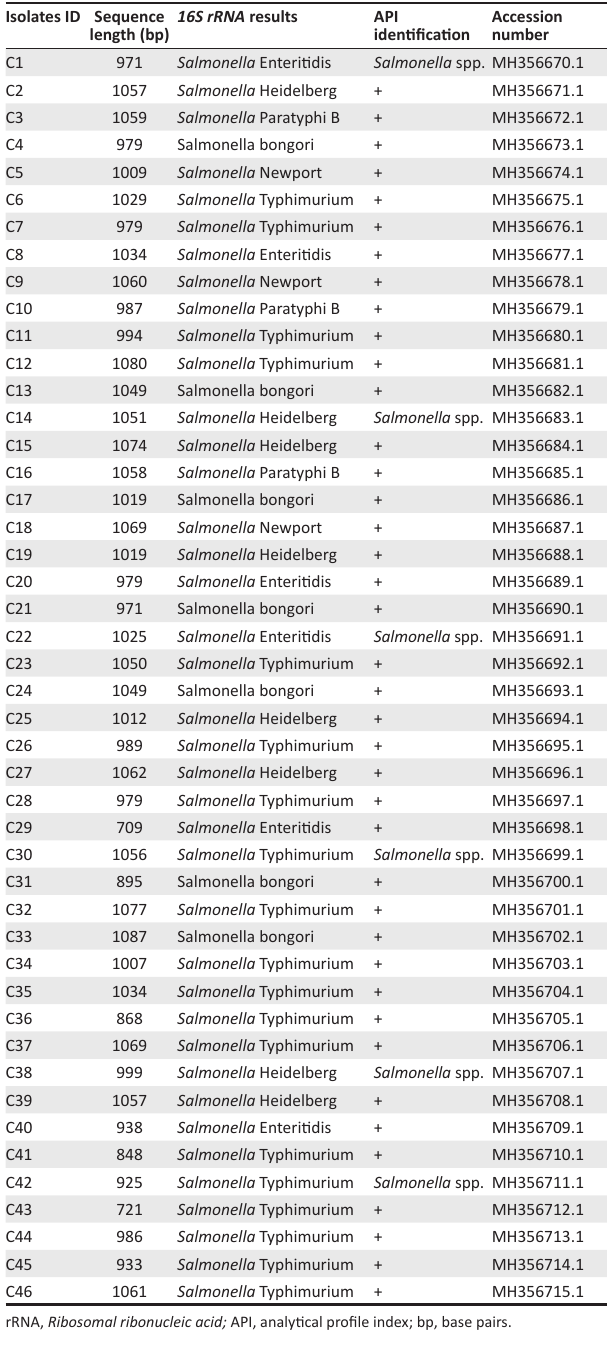
TABLE 2: Results of 46 isolates for analytical profile index, 16S Ribosomal ribonucleic acid sequencing (polymerase chain reaction) and accession number. Isolates ID Sequence 16S rRNA length (bp)